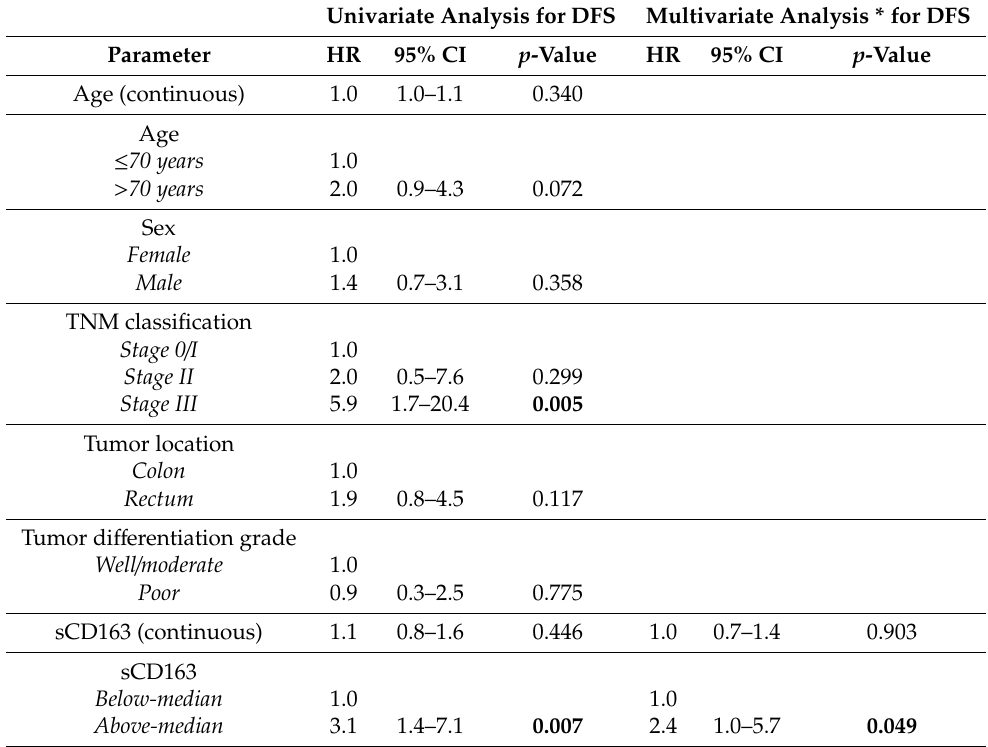
Table 2. Univariate and multivariate analyses of sCD163 serum levels for the DFS of CRC patients. Univariate and multivariate analyses for DFS were generated for stage 0–III CRC patients ( N = 58). The median sCD163 level (2.0 mg / L) was used as a cuto ff . Statistically significant p -values ( ≤ 0.05) are indicated in bold. Abbreviations: CI (confidence interval), CRC (colorectal cancer), DFS (disease-free survival), HR (hazard ratio), sCD163 (soluble CD163), TNM (tumor, node, metastasis).